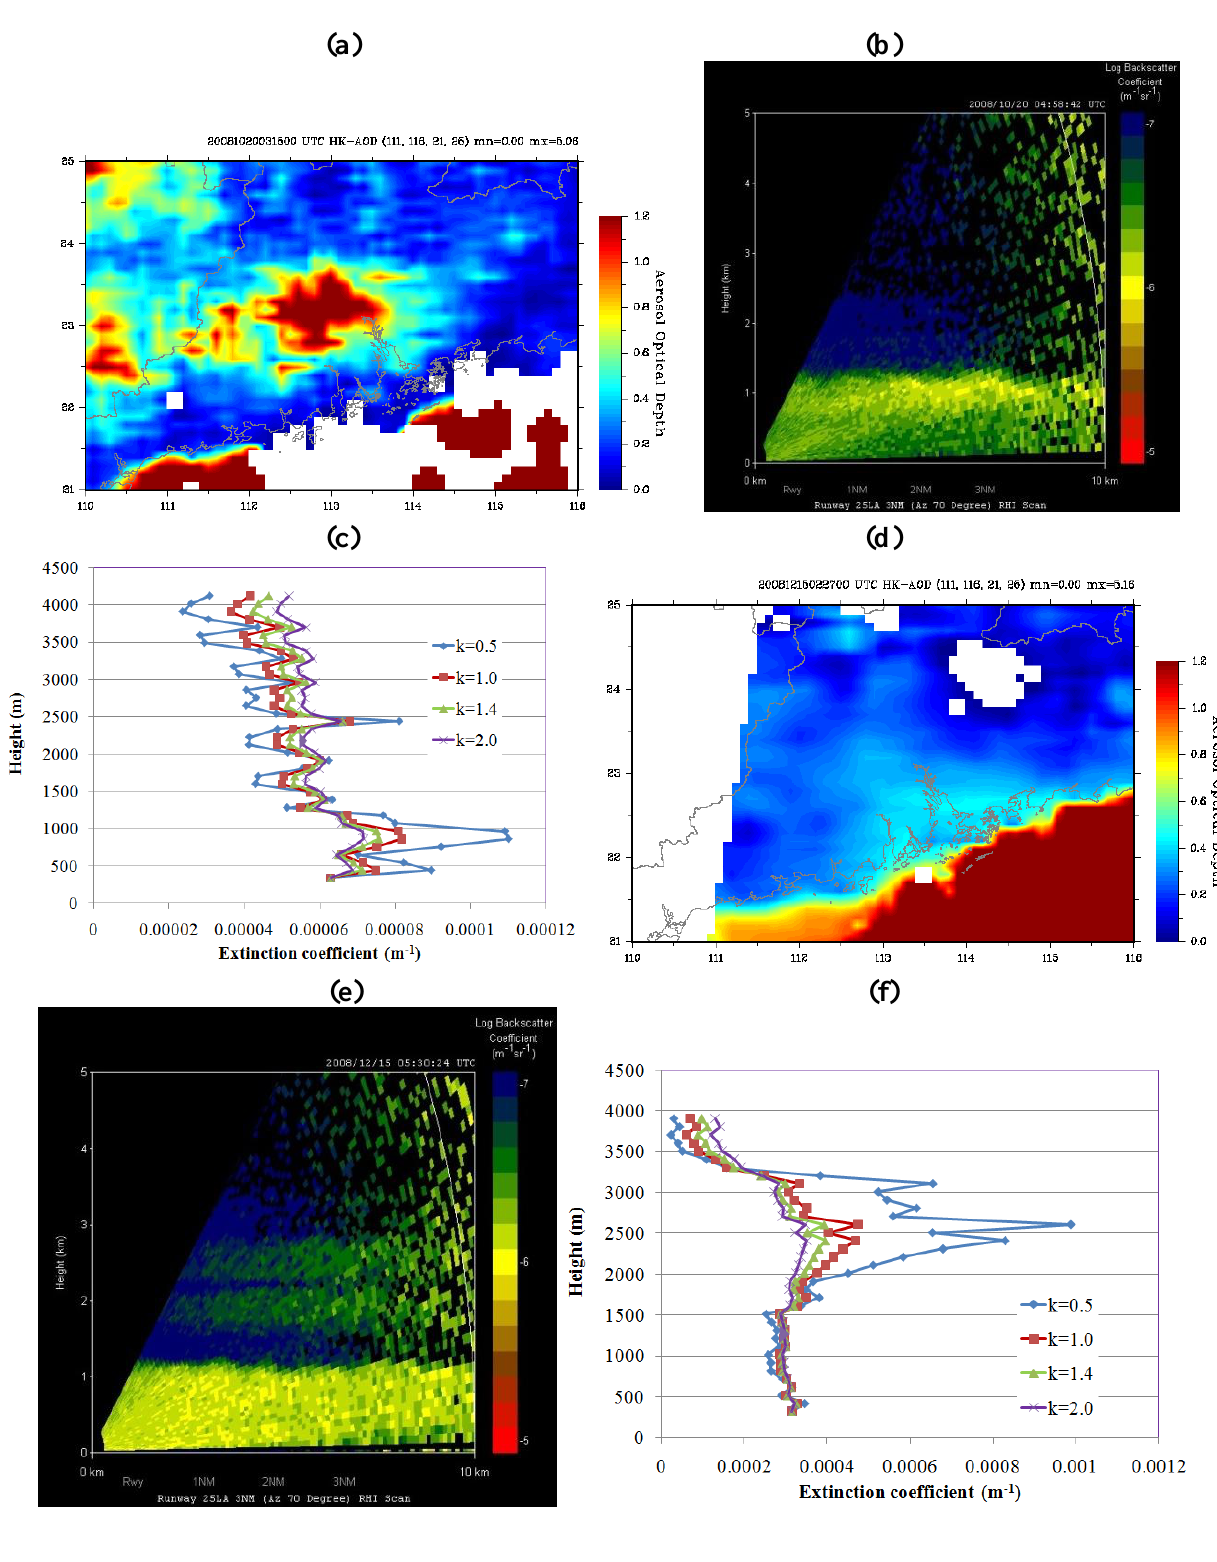
Figure 6. Data plots for the two events under study in this paper, namely, 20 October 2008: (a) MODIS AOD map at 03:16 UTC, 20 Oct 2008, (b) LIDAR RHI plot of backscattered power, (c) LIDAR-derived extinction coefficient profiles, and 15 December 2008: (d) MODIS AOD map at 02:27 UTC, 15 Dec 2008, (e) LIDAR RHI plot of backscattered power, (f) LIDAR-derived extinction coefficient